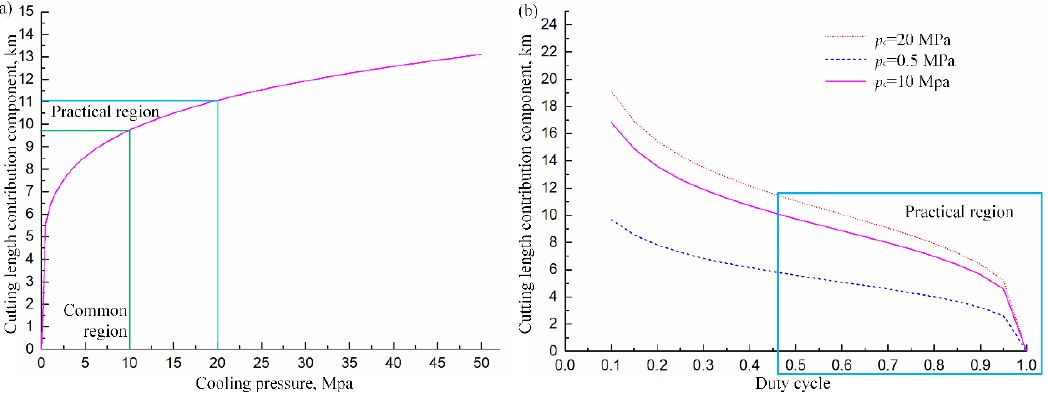
Figure 9. Tool life contribution components of HUVC of Ni alloys, ( a ) effects of cooling pressure, duty cycle is 0.5 and ( b ) effects of duty cycle. Feed per revolution and cutting depth are 0.005 mm/r and 0.2 mm, respectively. p c , cooling pressure.